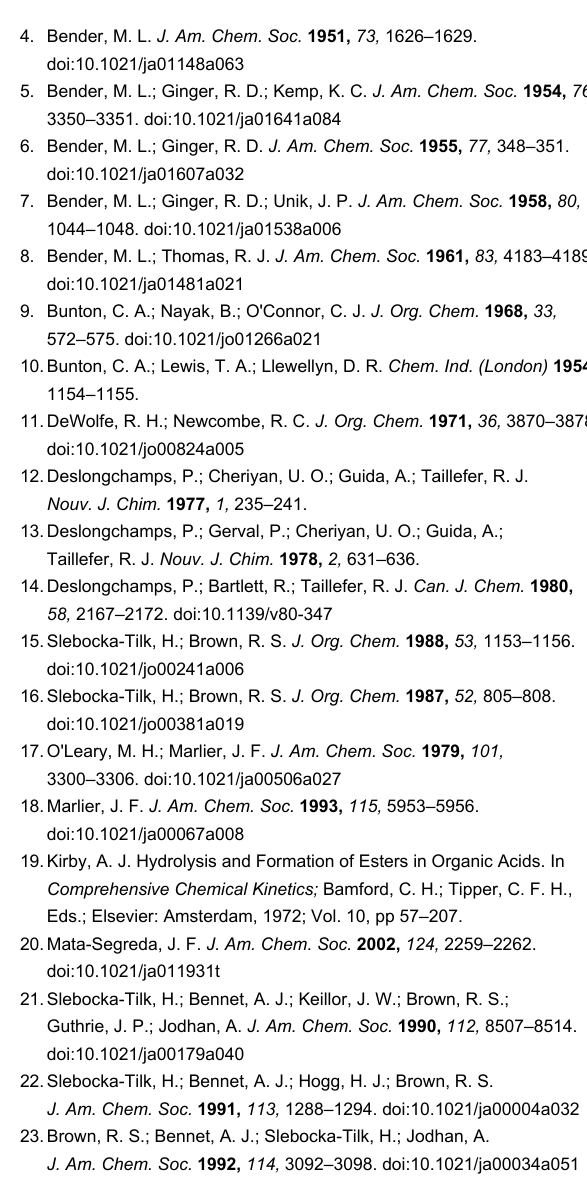
This work has demonstrated that proton transfers along hydrogen bonds have a significant role on the progress of the